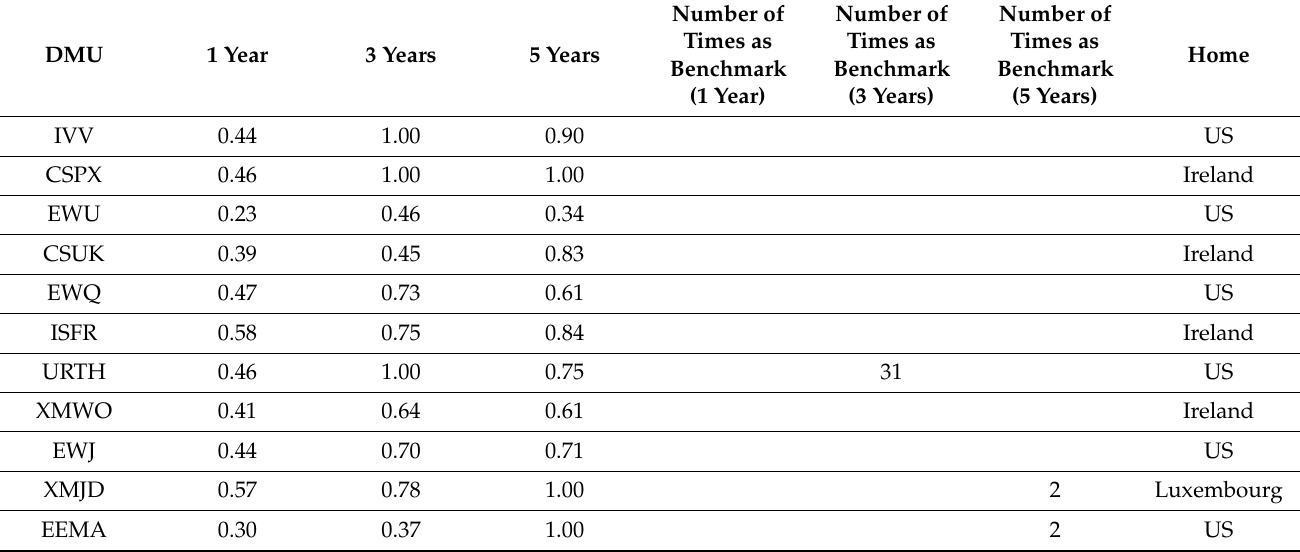
Table A7. Efficiency scores and benchmarks computed with model